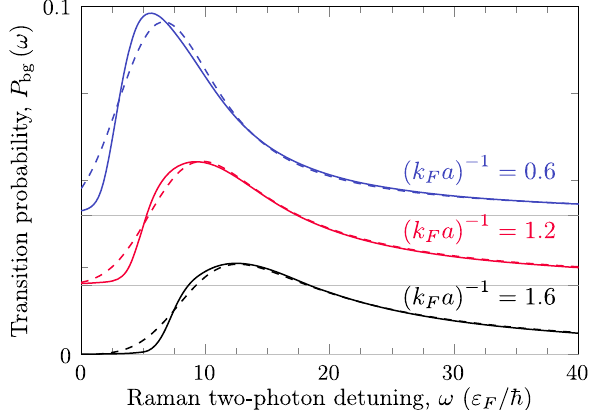
FIG. 11. Comparison of background Raman spectra. Using the full many-body model for the Raman spectra [incoherent and molecular terms in Eq. (5), solid lines] and the approximation obtained by fitting the simplified model Eq. (13) to the theoretical spectra (dashed lines), Raman spectra are shown for three interaction strengths. For clarity, the second and third graphs from the bottom are shifted by 0.02 and 0.04, respectively.